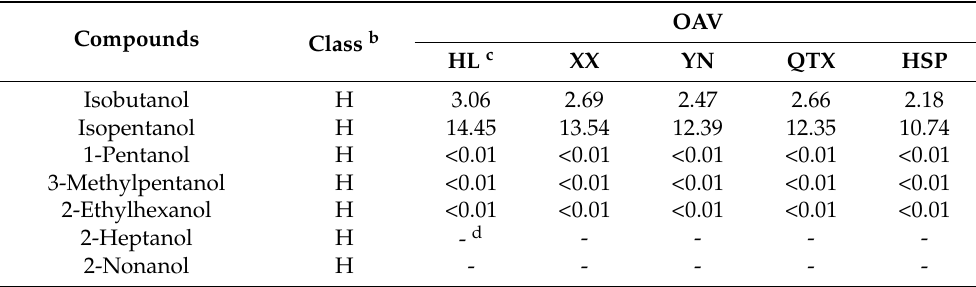
Table 2. OAVs of volatile compounds in Cabernet Sauvignon dry red wines from five sub-regions of the Eastern Foothills of Helan Mountain in Ningxia a